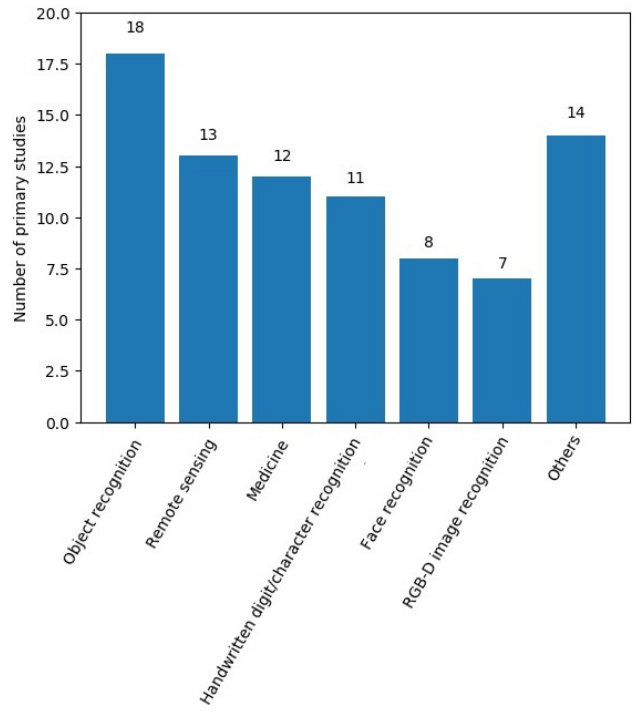
Figure 3. Main application scenarios of